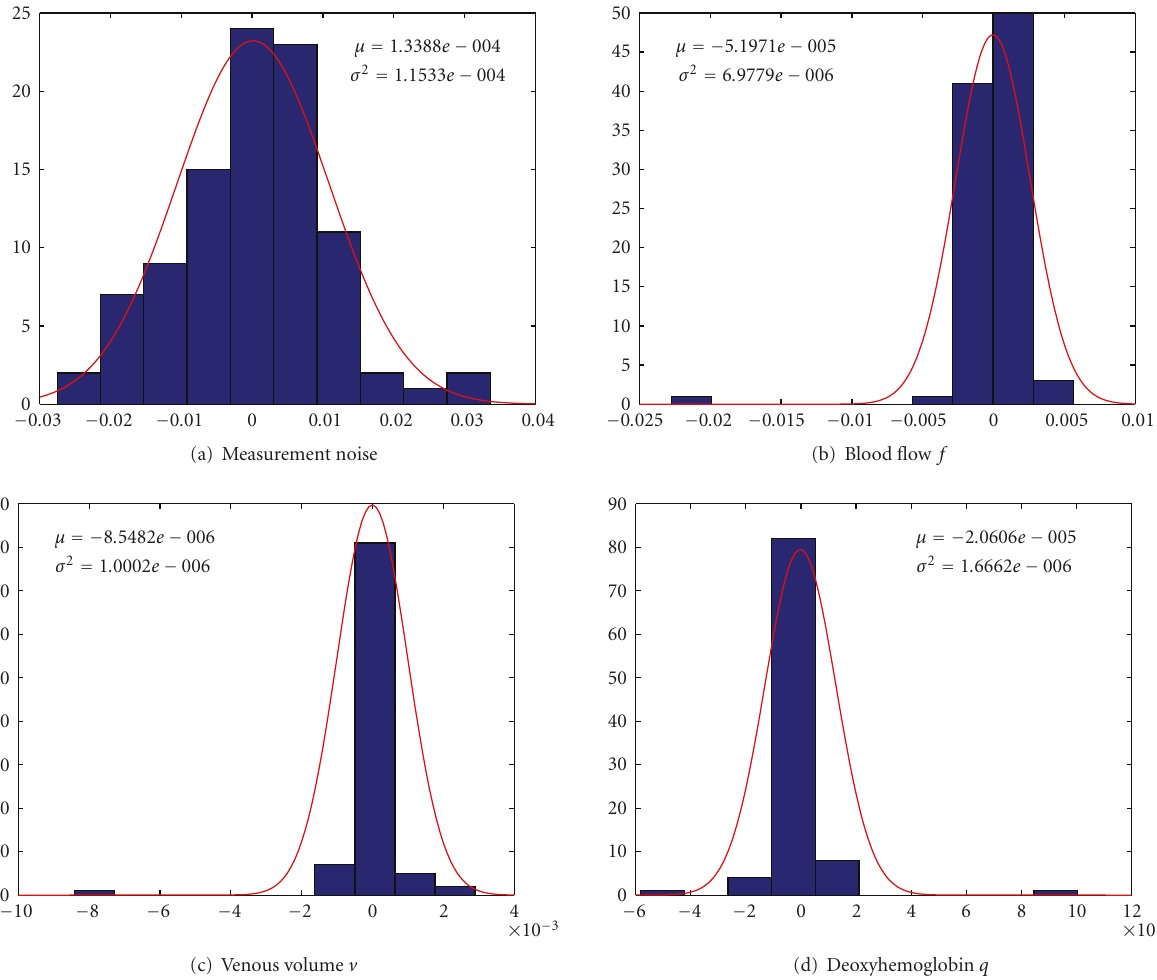
Figure 7: The histogram of estimated measurement and physiological noise from synthetic data. The red line represents fitted Gaussian